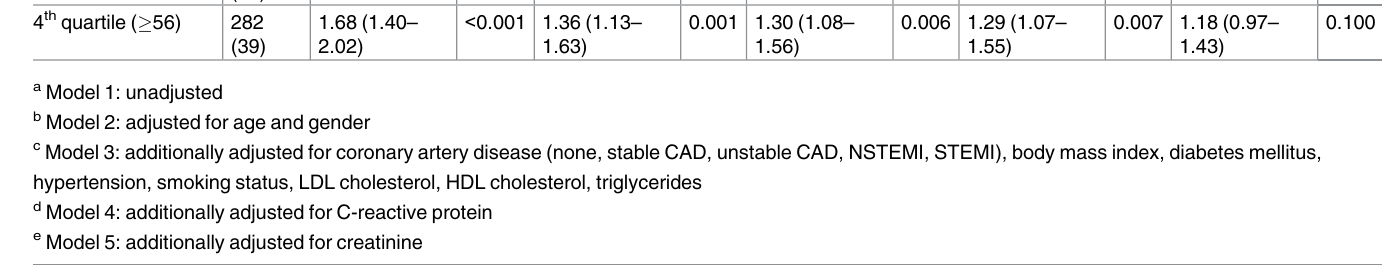
CAD, NSTEMI and STEMI (data not shown). Adjusting for creatinine abolished the signifi- cant associations of NGAL with mortality (model 5, Tables 3 and 4). We conducted a subgroup analysis according to an eGFR greater versus smaller (or equal) 60 ml/min/1.73m 2 . All cause and cardiovascular mortality rates were considerably higher (60.3% vs. 25.1% and 42.0 vs.15.5%, respectively) in those patients with low compared to higher eGFR ( > 60 ml/min/ 1.73m 2 ) (Tables 5 and 6).